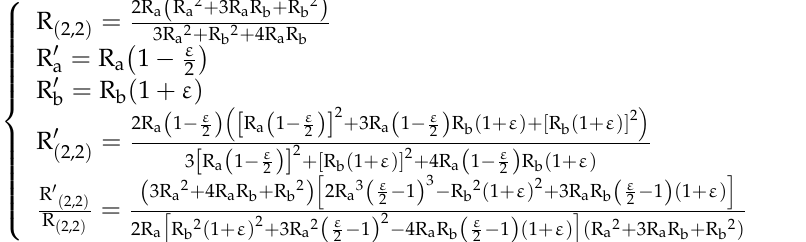
R (cid:48) ( /R ( of 2 courses × 2 wales can be calculated, as shown in Equation 2,2 ) 2,2 )